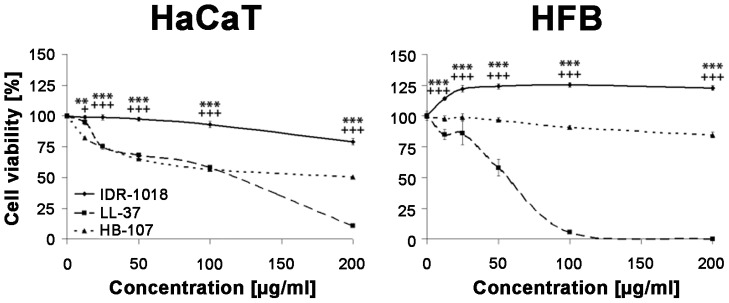
Lack of IDR-1018 toxicity.The effects of IDR-1018, LL-37 and HB-107 on viability/metabolic activity were determined using an MTT-Assay with HaCaT cells (left) and primary human fibroblasts (HFB; right) at the indicated concentrations. Cells were incubated with peptides for 24 hours. Standard deviation was calculated out of three independent experiments and assessed as SEM (Statistical significance IDR-1018 vs. LL-37: *  = p<0.05; **  = p<0.01; ***  = p<0.005; IDR-1018 vs. HB-107+ = p<0.05).